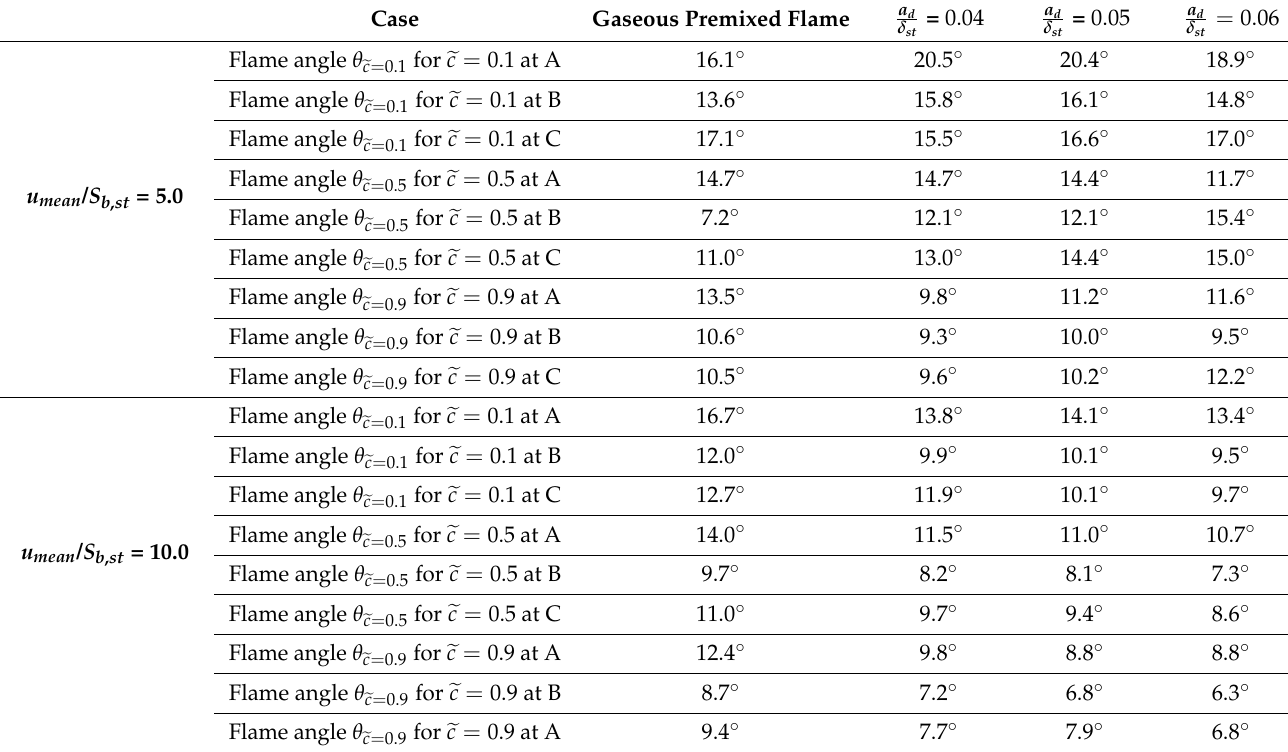
Table 2. Flame angle θ (i.e., the angle the tangent on the (cid:101) c isosurface at a given location makes with the midline) for (cid:101) c isosurfaces.